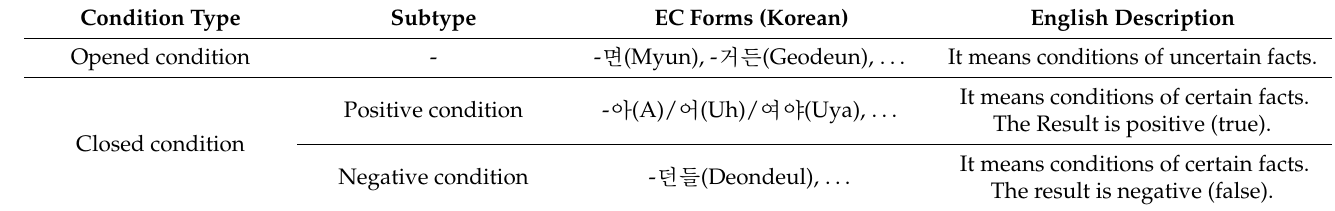
Table 3. Part of Condition types [8] in the Korean language.